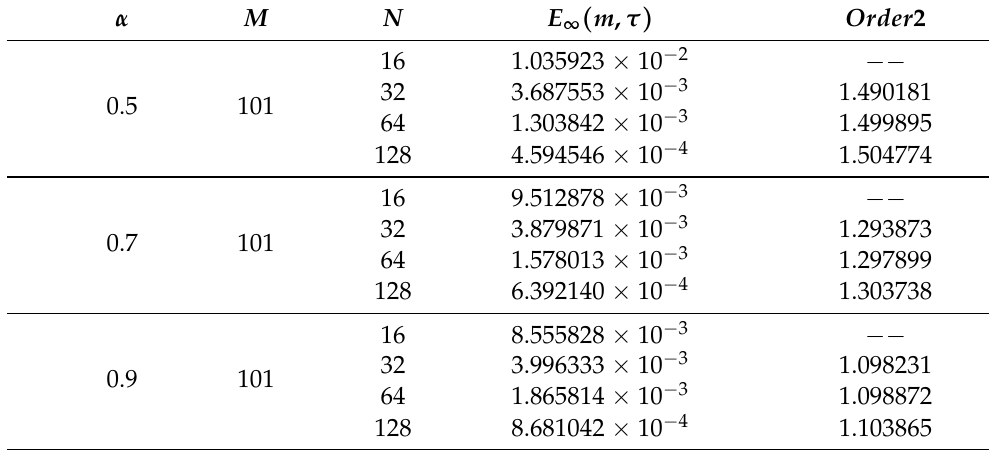
Table 3. Numerical error and temporal convergence order of HASC-N difference scheme for Example 1.